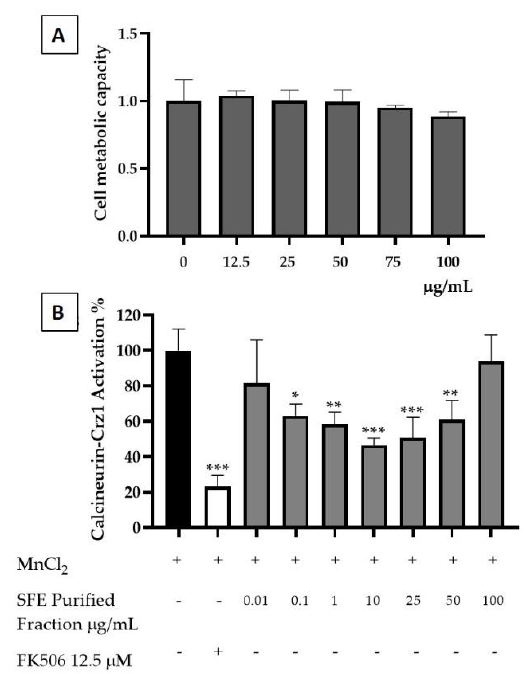
Figure 9. Purified fraction potential for inhibiting calcineurin/Crz1 activation. ( A ) Toxicity was evaluated at the indicated concentrations of the SFE purified fraction. ( B ) Anti-inflammatory potential of SFE purified fraction demonstrated by the inhibition of the calcineurin/Crz1 pathway in S. cerevisiae . Statistical differences are noted as * p < 0.1, ** p < 0.01, *** p < 0.001 relative to the activated control (cells treated with MnCl 2 ).